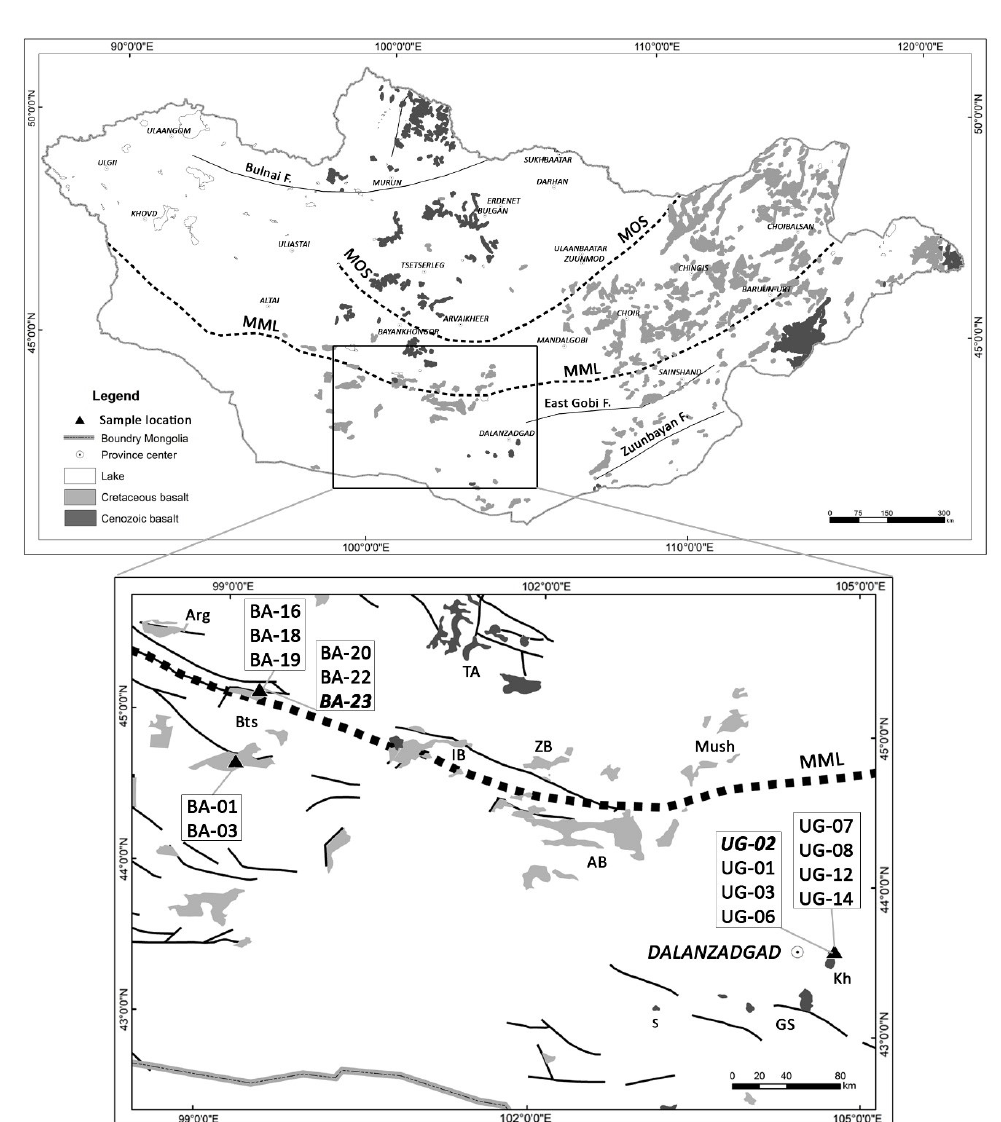
Fig. 1. Simplified tectonic outline and distribution of Mesozoic-Cenozoic volcanic rocks in Mongolia (modified after Yarmolyuk et al., 2011, Barry, 1999). Sample localities and numbers of this study also showed. MOS: Mongol-Okhotsk suture; MML: Main Mongolian Linement. Abbreviation names are as follows: Arg-Argalant; Bts-Bayantsagaan; IB-Ikh bogd; ZB-Zuunbogd; AB-Ajbogd; Mush-Mushgai; Kh-Han-Uul; GS-Gurvansaikhan; TA-Taatsiin